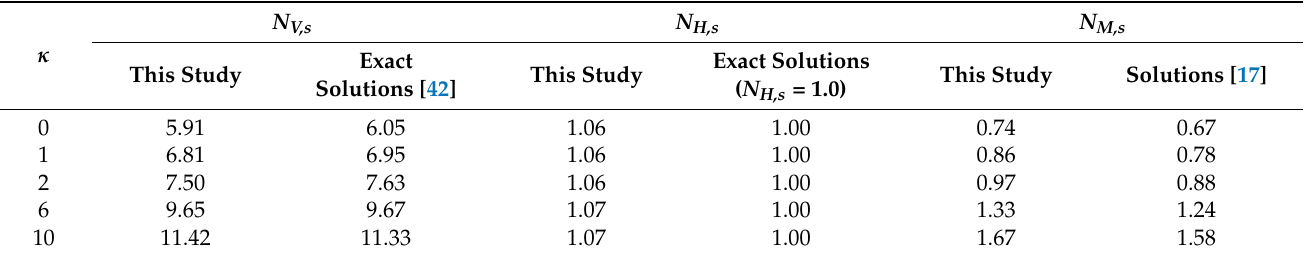
Table 1. Comparisons between finite-element results in this study and existing theoretical solutions for uniaxial capacities of single circular